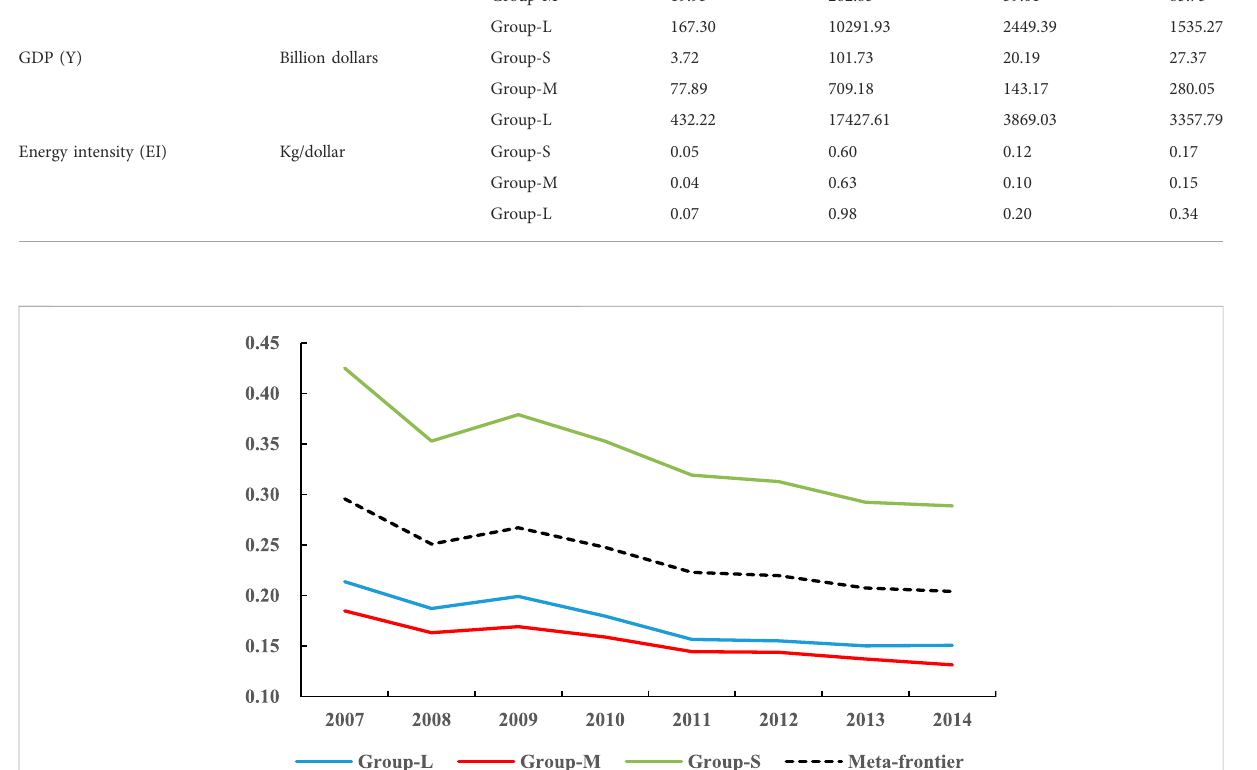
FIGURE 2 Evolution trend of energy intensity for each group, 2007 –